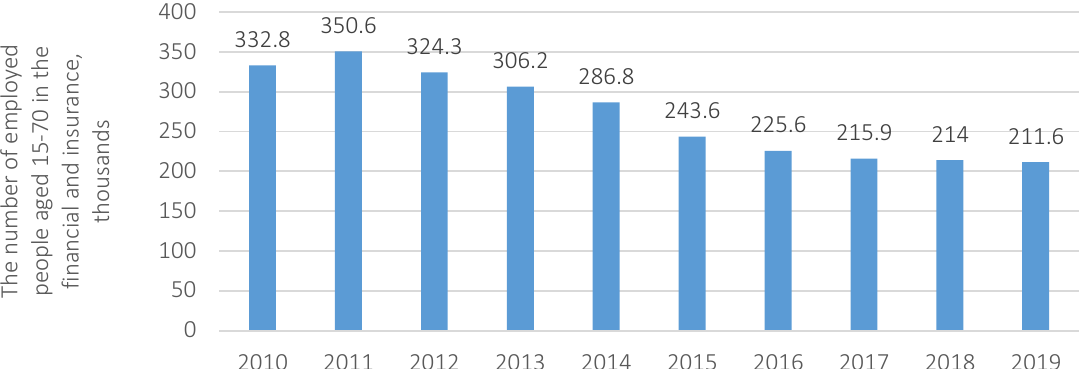
Figure 4. The number of employed population in the financial and insurance